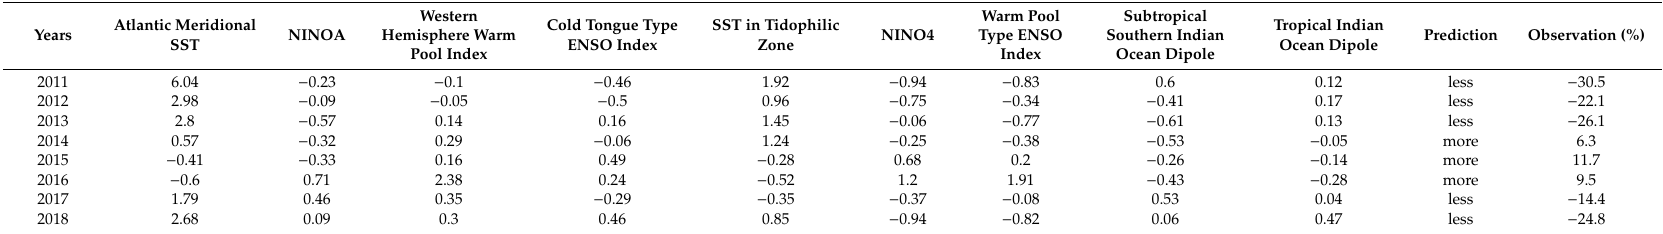
Table 4. Test table for predicting summer precipitation e ff ect from 2011 to 2018 based on the winter SST index decision tree model in Chongqing.